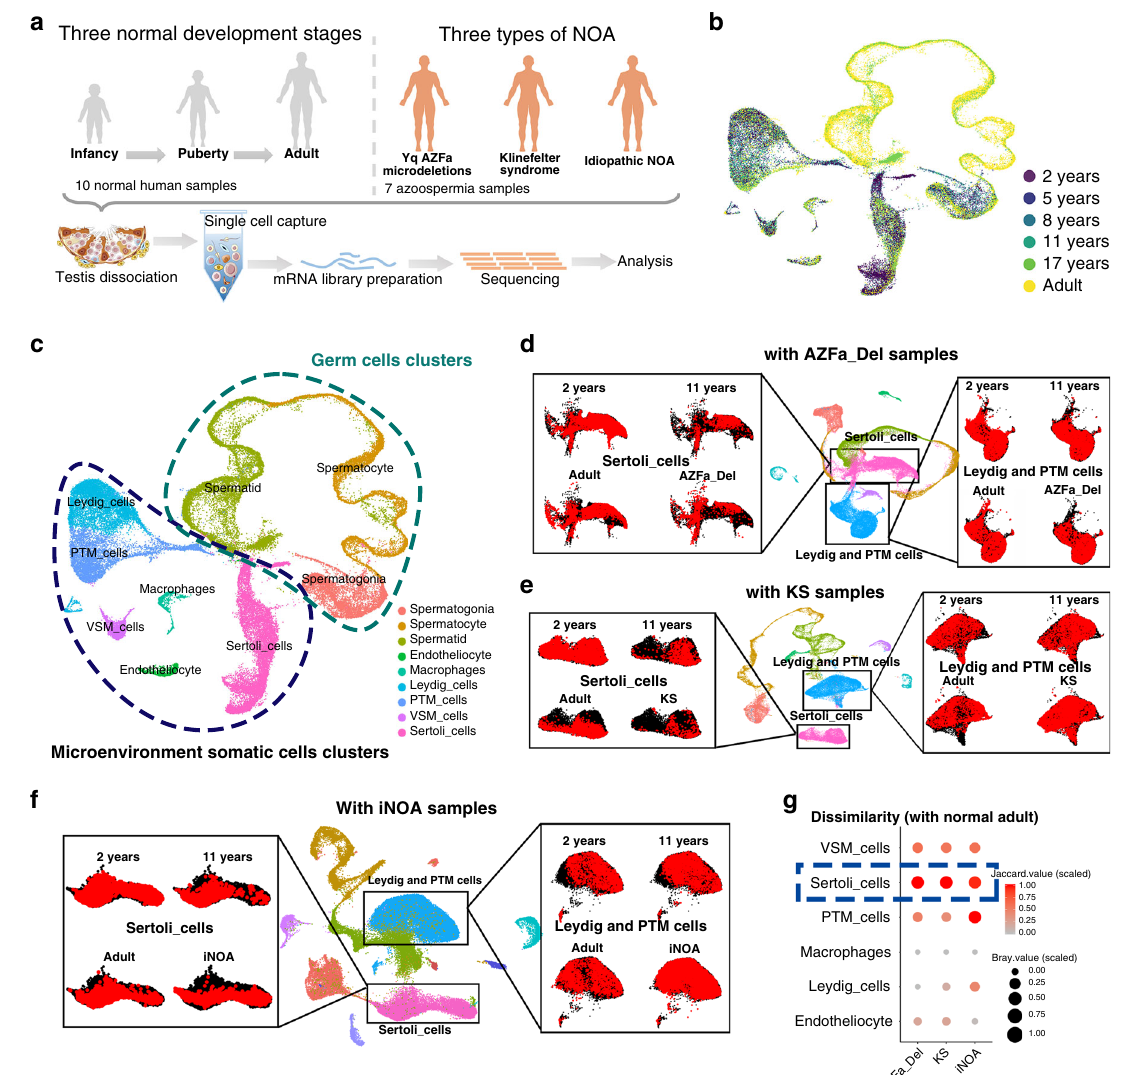
Fig. 1 Global expression pro fi ling of human testicular cells from infancy to adulthood and in NOA patients by single-cell RNA-seq. a Schematic illustration of the experimental work fl ow. b , c UMAP plots of all testicular cells from 10 healthy subjects. Cells are colored for b ages or c types. UMAP, uniform manifold approximation and projection. d – f UMAP plots of all testicular cells from 10 healthy subjects merged with d 1 case of AZFa_Del, e 3 cases of KS, or f 3 cases of iNOA samples. Sertoli cells (left panels) or Leydig&PTM cells (right panels) are isolated and highlighted as red according to the sample type. g Dissimilarity of somatic cells between normal adult and AZFa_Del, KS or iNOA are shown on bubble diagram. The gradient of bubbles sizes indicates low to high scaled Bary value, and the gradient of red indicates low to high scaled Jaccard values. Some elements in panel a were downloaded from Servier Medical Art repository. Note: peritubular myoid cells (PTM_cells), vascular smooth muscle cells (VSM_cells); Yq AZFa microdeletions (AZFa_Del); Klinefelter Syndrome (KS); idiopathic NOA